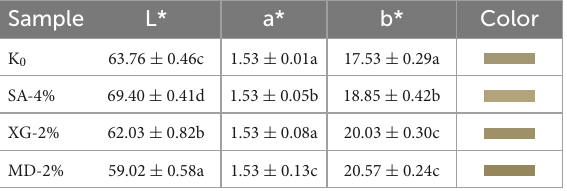
TABLE 2 Colour value of extrudates with different polysaccharides.